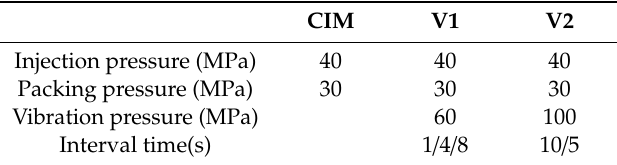
Table 1. Molding parameters of vibration injection molding process.